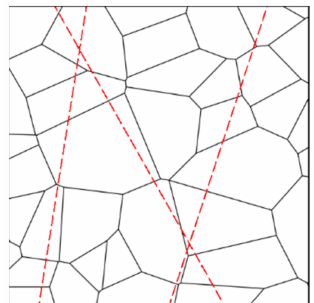
Figure 8. Schema of random cracks in a two-dimensional microstructure. Grain boundaries are simplified drawn with black straight lines. Random straight cracks are drawn with dashed red lines.